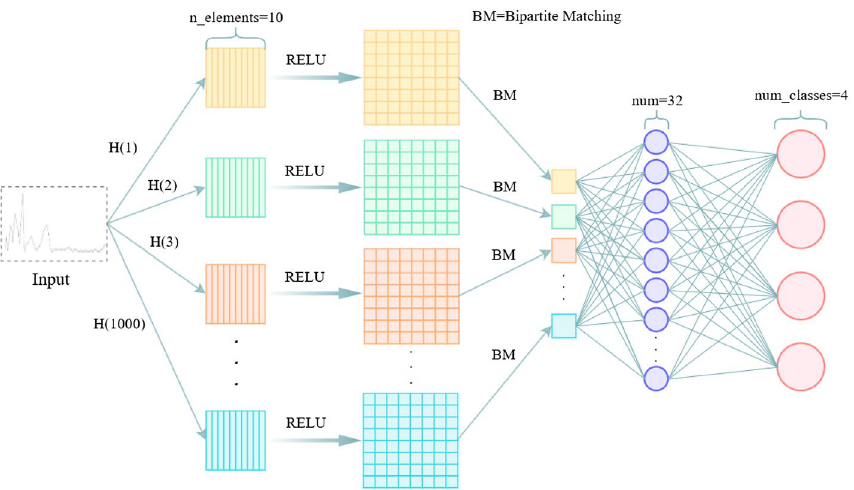
Figure 6. Improved RepSet model structure (this figure is the second edition. Its link is https:// www. jiang uoyun. com/p/ DSCmu 0wQmq TyCRj 3vdsE